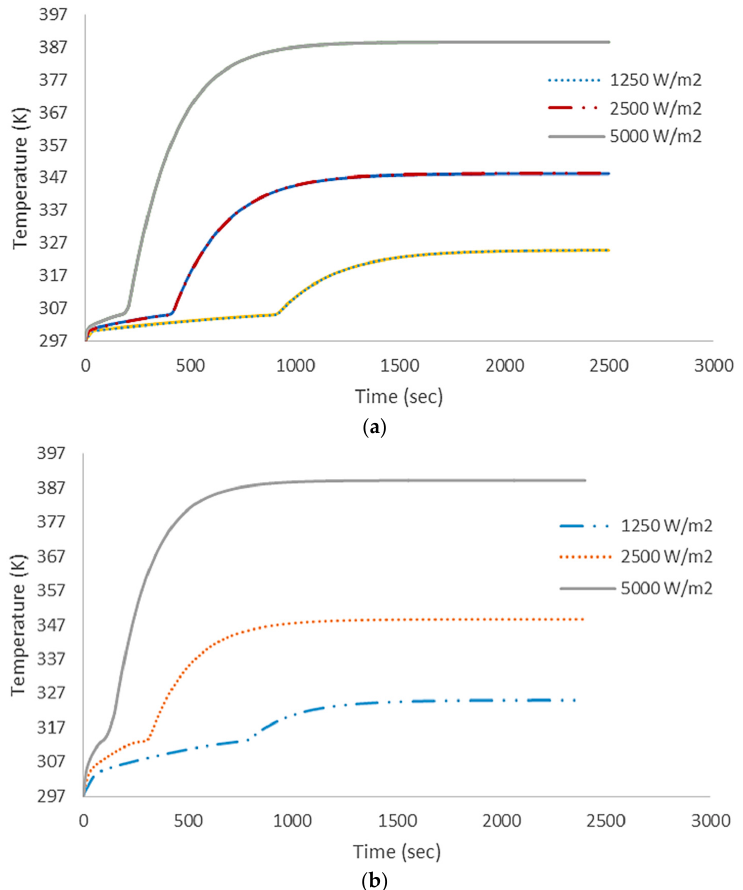
Figure 10. Variation of the sink temperature under three different heat fluxes using ( a ) Salt hydrate; ( b )